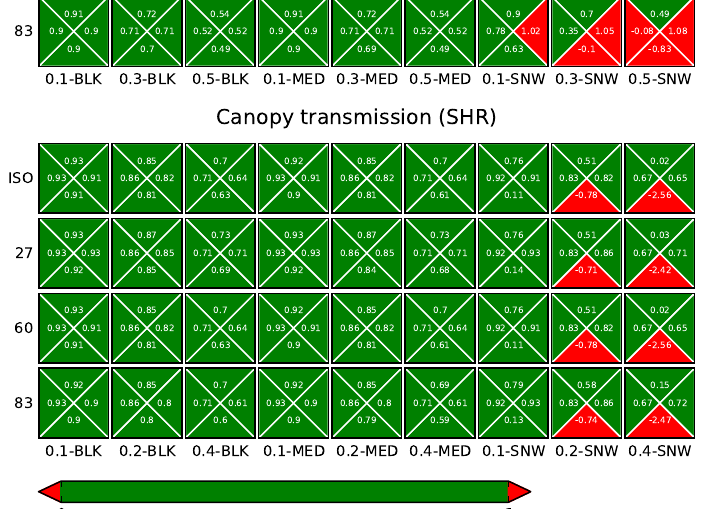
Fig. A5. Canopy transmission as calculated using Eq. (24) by assuming energy conservation. Red labels indicate a clear inconsistency in the canopy flux estimates. Details of figure structure are the same as Fig. 3